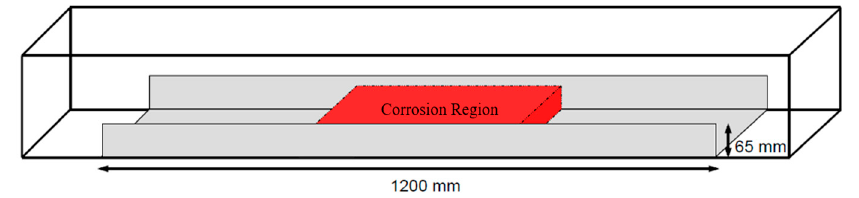
Figure 3. Details setup of CFRP Sheet external strengthening.